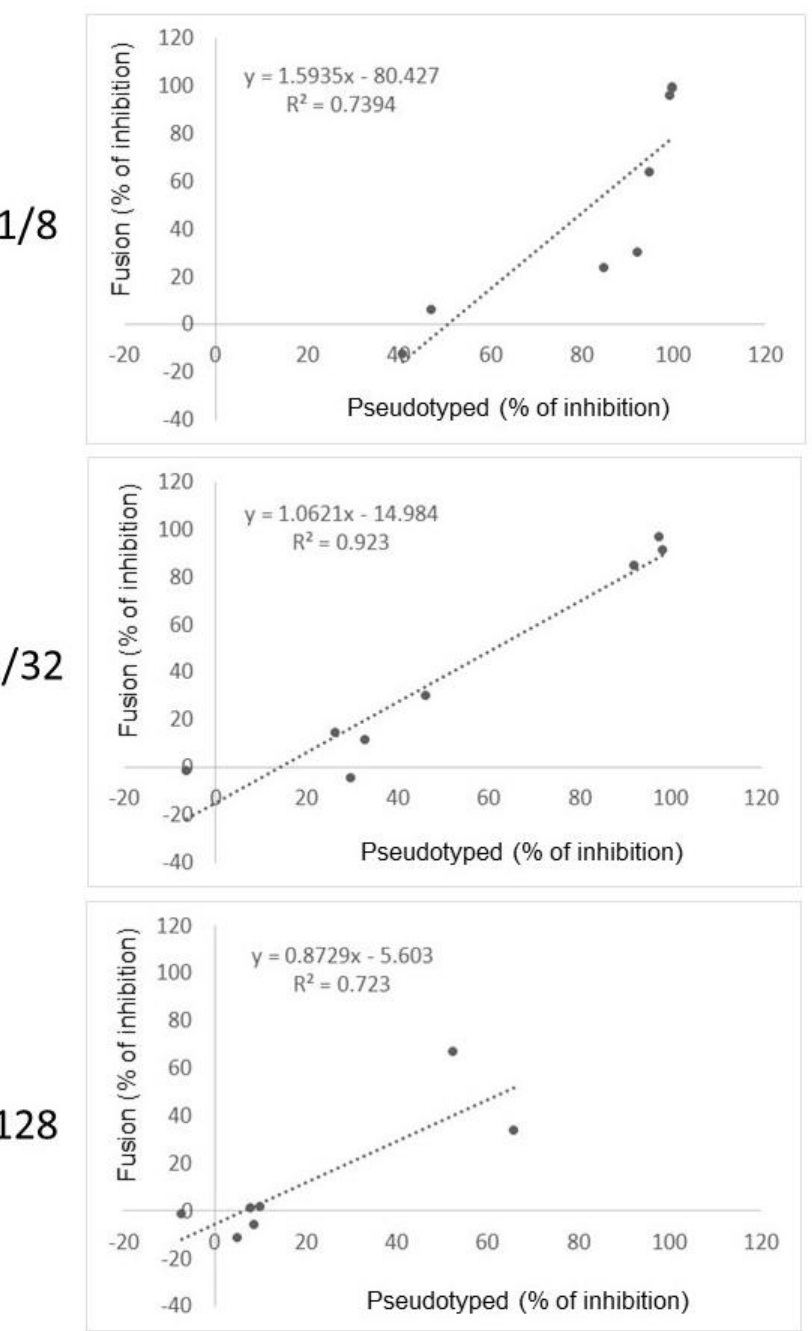
Figure 6. Comparison of the fusion-based assay with a pseudotyped-based entry assay. Height sera were either analyzed, for each indicated dilution, with the fusion-based assay or an assay using a Spike/luciferase-expressing lentivector.